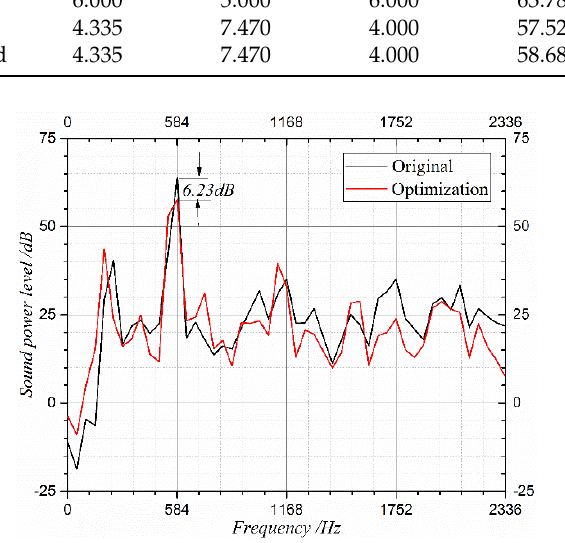
Figure 27. The radiated sound power spectrum of the volute structural surface.